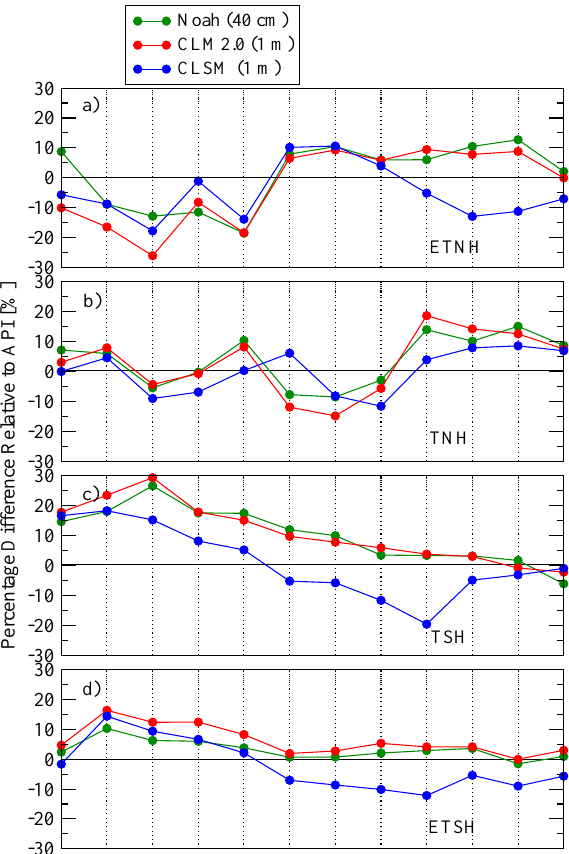
Fig. 8. Spatial averages of R( − 1 ) for Noah, CLM2.0, CLSM, and API broken down by month of the year for Rank ( ¯ θ) within the (a) extra-tropical Northern Hemisphere (ETNH), (b) tropical Northern Hemisphere (TNH), (c) tropical Southern Hemisphere (TSH), and (d) extra-tropical Southern Hemisphere (ETSH).